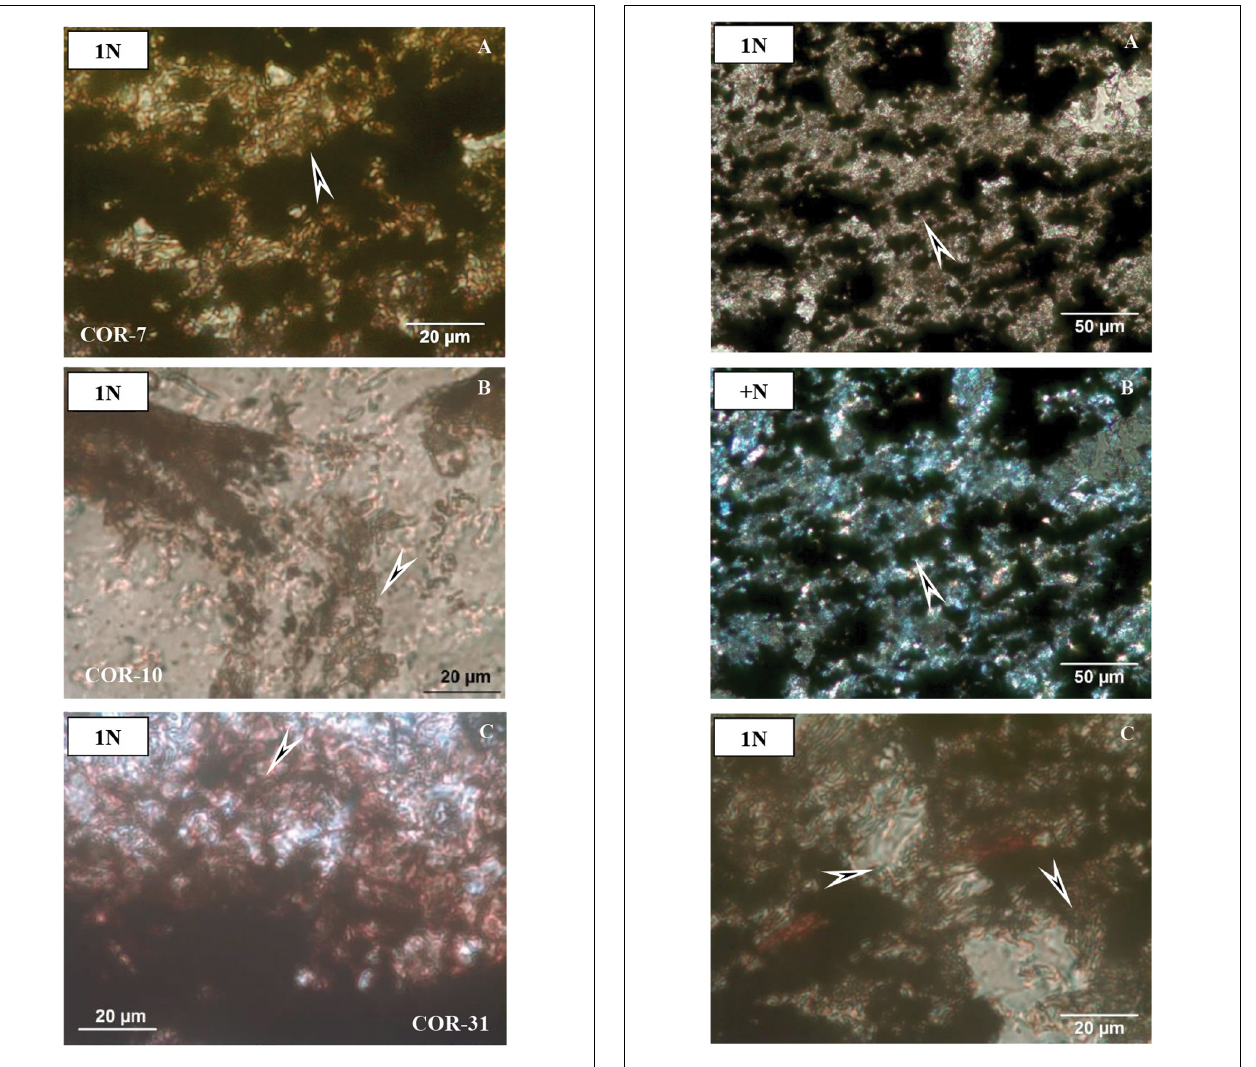
FIGURE 4 | Microtextural features of sample COR-7 by OM. (A) Biomat-like forms (arrow, 1N, and transmitted light). (B) Crossed N of (A). (C) Mineralized microbial biosignatures (arrows, transmitted light, and